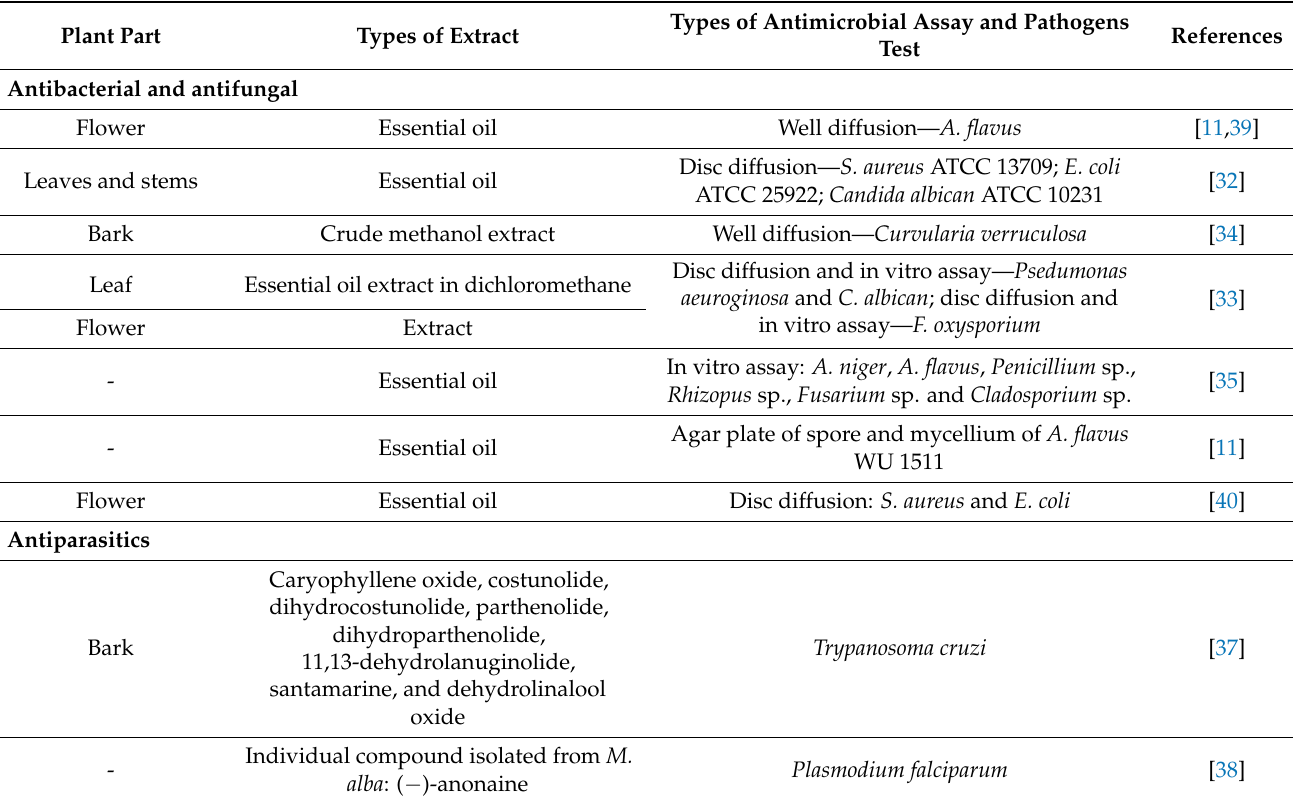
Table 2. Antimicrobial activities screening from different part of Michelia x alba